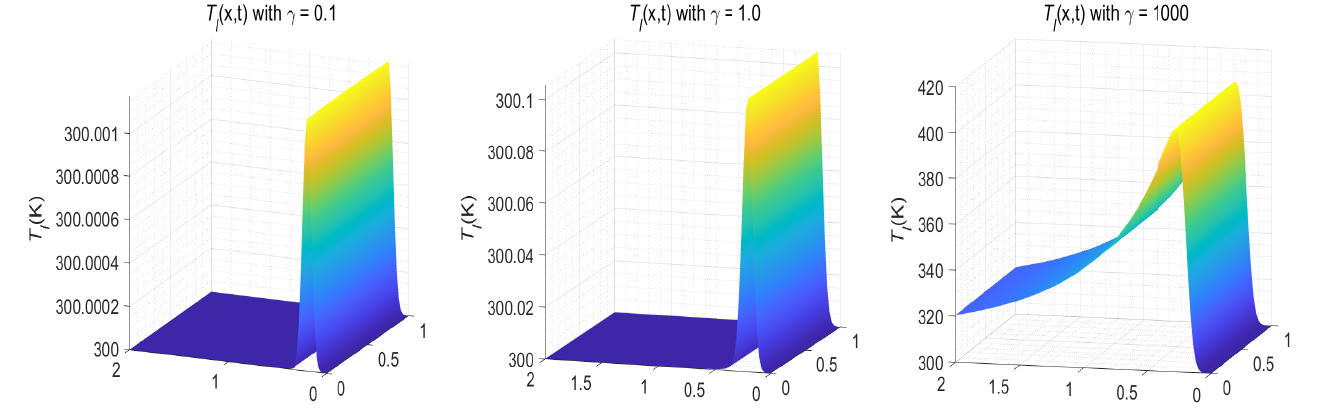
Figure 18. Temperature distributions of T l versus ( x , t ) with various γ when K n = 618.4658, ( α , β ) = ( 0.8,0.3 ) , N = 100, and M = 100 for Example 2.